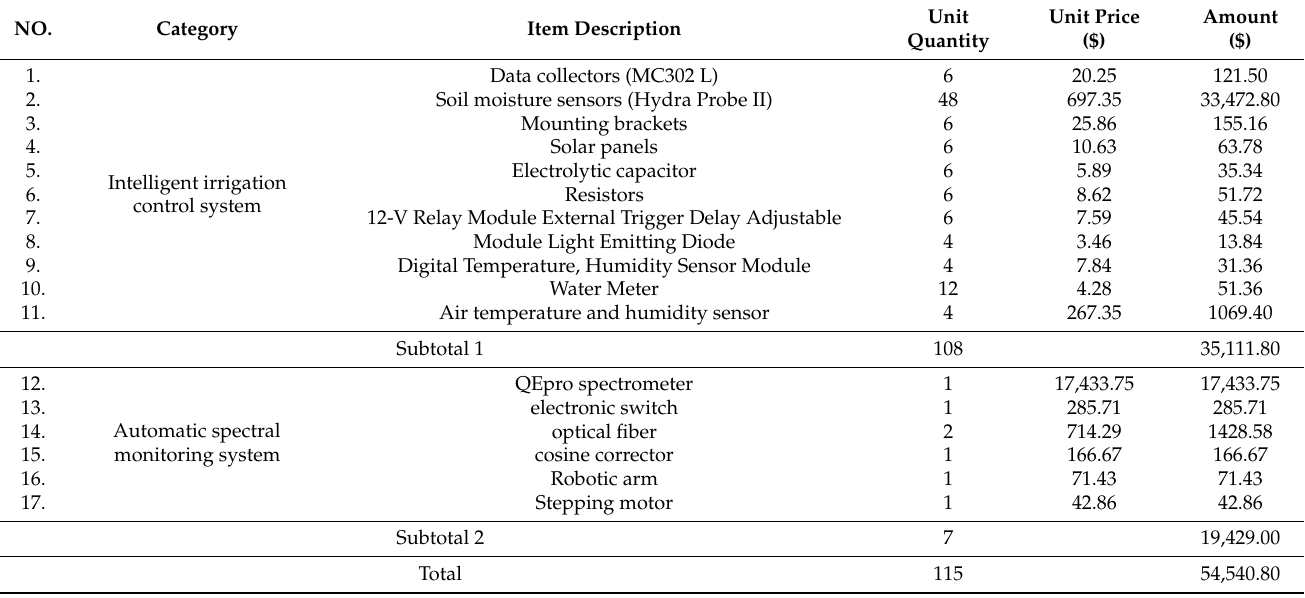
Table 4. Cost analysis of the Intelligent Irrigation Control System and Automatic Spectral Monitoring